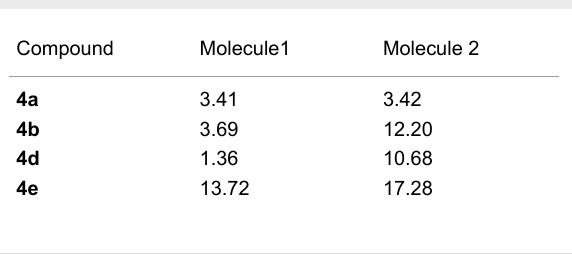
Table 2: Angles (°) between the planes of the aromatic ring and neigh- bouring pyrrole ring in 4a,b,d,e